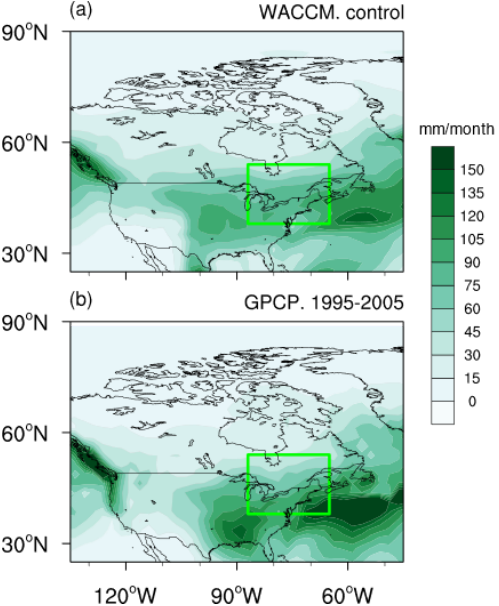
Figure 7. ( a ) Climatological distribution of April rainfall (mm/month) in the control experiment (E1). ( b ) Same as ( a ), but for GPCP-derived rainfall during the period 1995 – 2005.